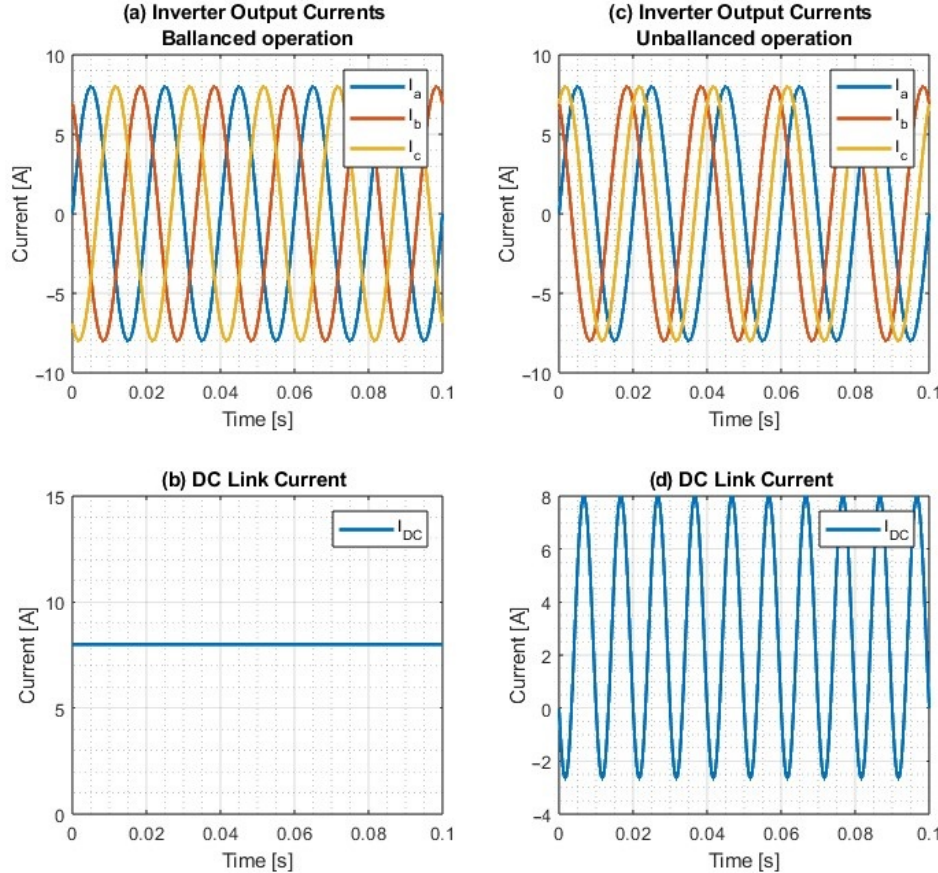
Figure 2. DC link current in the case of balanced ( a , b ) and unbalanced ( c , d ) operation of the four‑wire inverter.